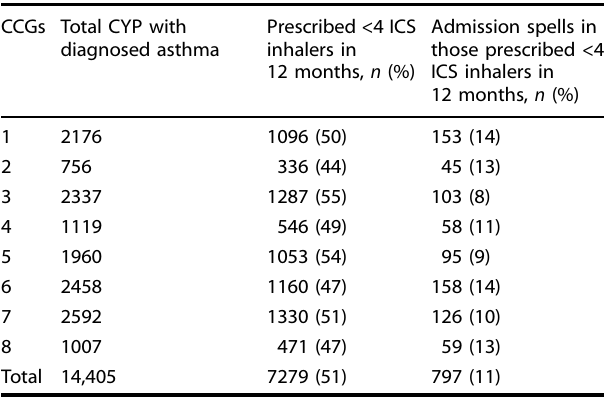
Table 3. Admission spells of those children and young people who were prescribed <4 inhaled preventer inhalers in 12